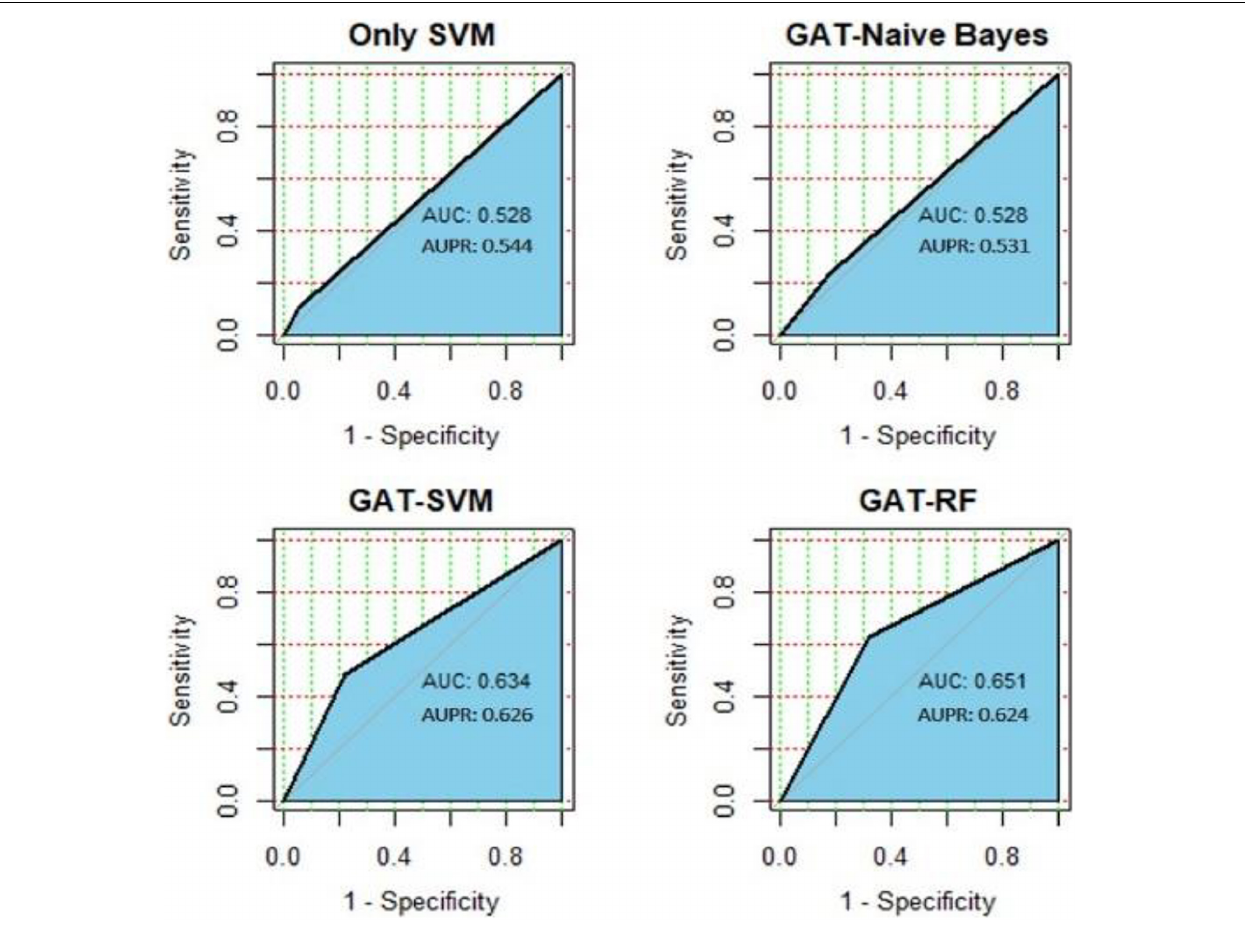
FIGURE 3 | Results of method comparison.